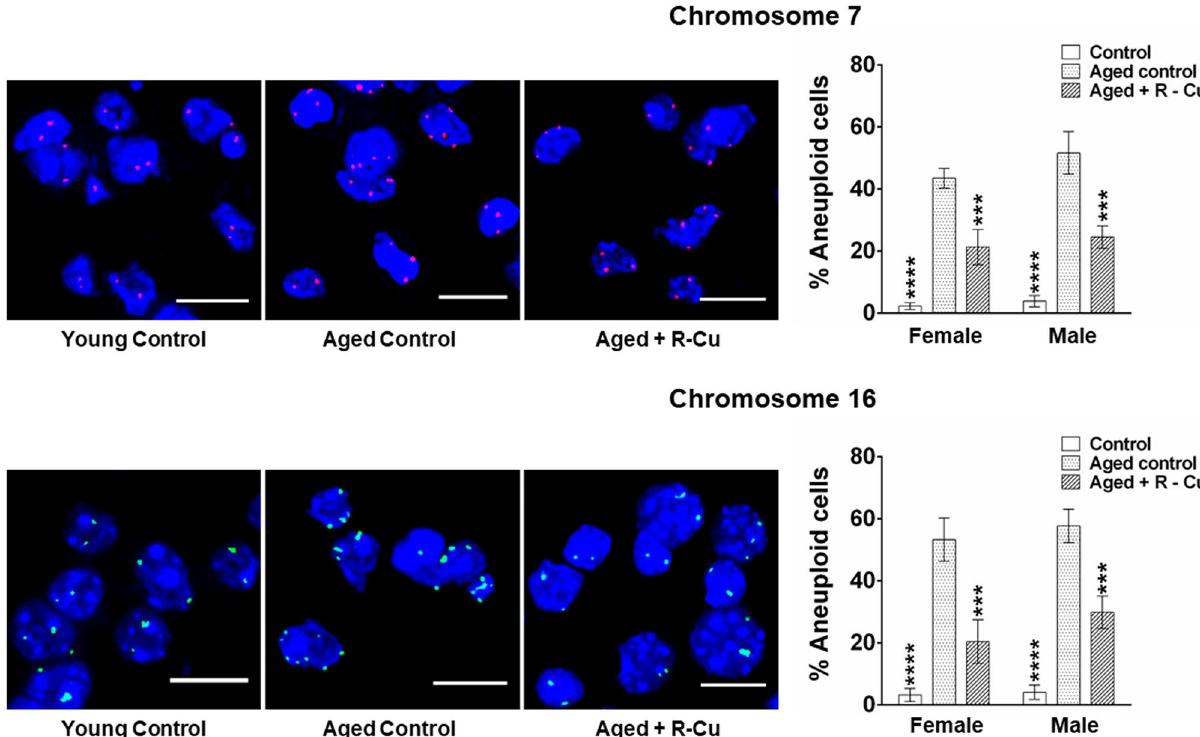
Figure 7. Development of aneuploidy in brain cells of ageing mice and its prevention by treatment with R–Cu. Representative images of aneuploidy of chromosome 7 and chromosome 16 in brain cells (left hand panels) (Scale bar = 10 µm). Quantitative histograms representing percent aneuploid cells (right hand panels). Number of fluorescent signals per nucleus was counted, and signals less than 2 N or more than 2 N in a nucleus were taken as evidence of aneuploidy. Five fields (~ 500 nuclei) were analysed and average number of signals per nucleus was calculated. Bars represent mean ± SEM values. N = 4 animals in each group of both sexes. Values in young controls and R–Cu treated ageing animals were compared with those of ageing controls, and statistical analysis was performed by two-tailed Student’s t test. *** p < 0.001; **** p <